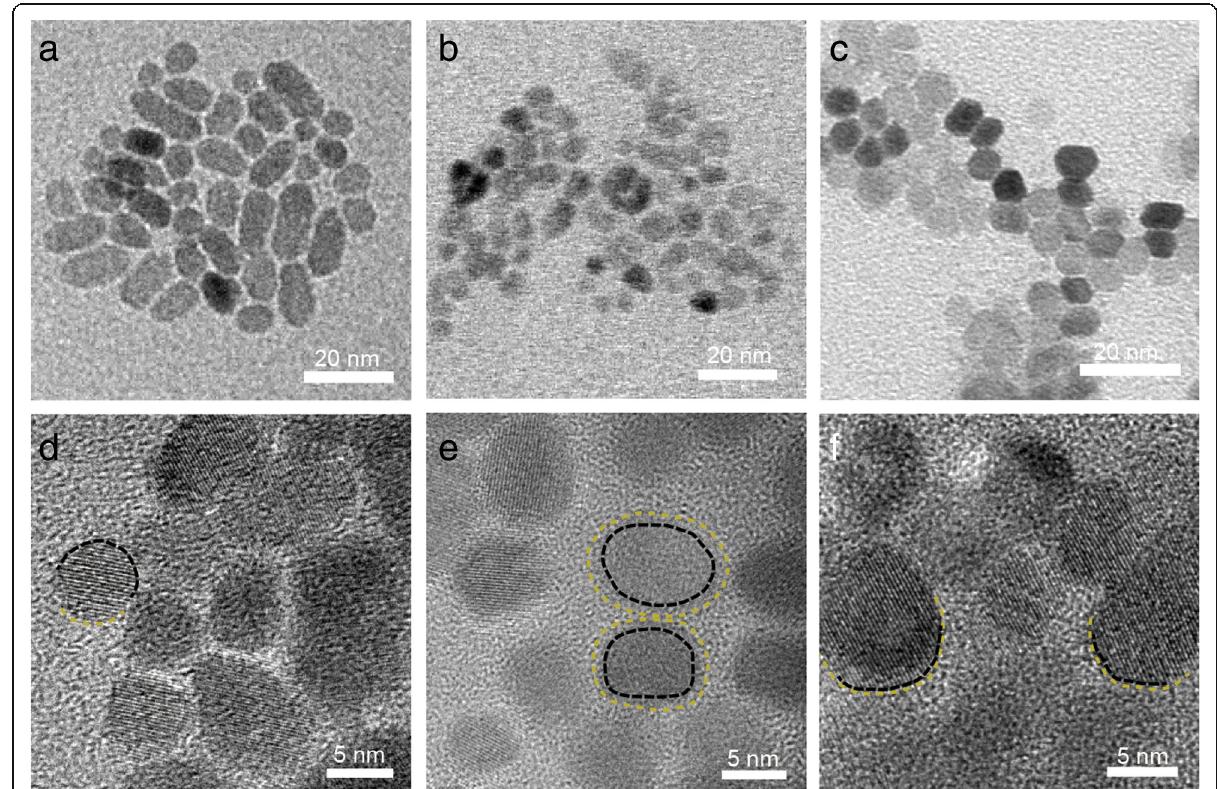
Fig. 6 TEM images of ZnO NPs at different stages of the growth process. a , d Primary nucleation. b , e flake-like aggregates. c , f Well-crystallized